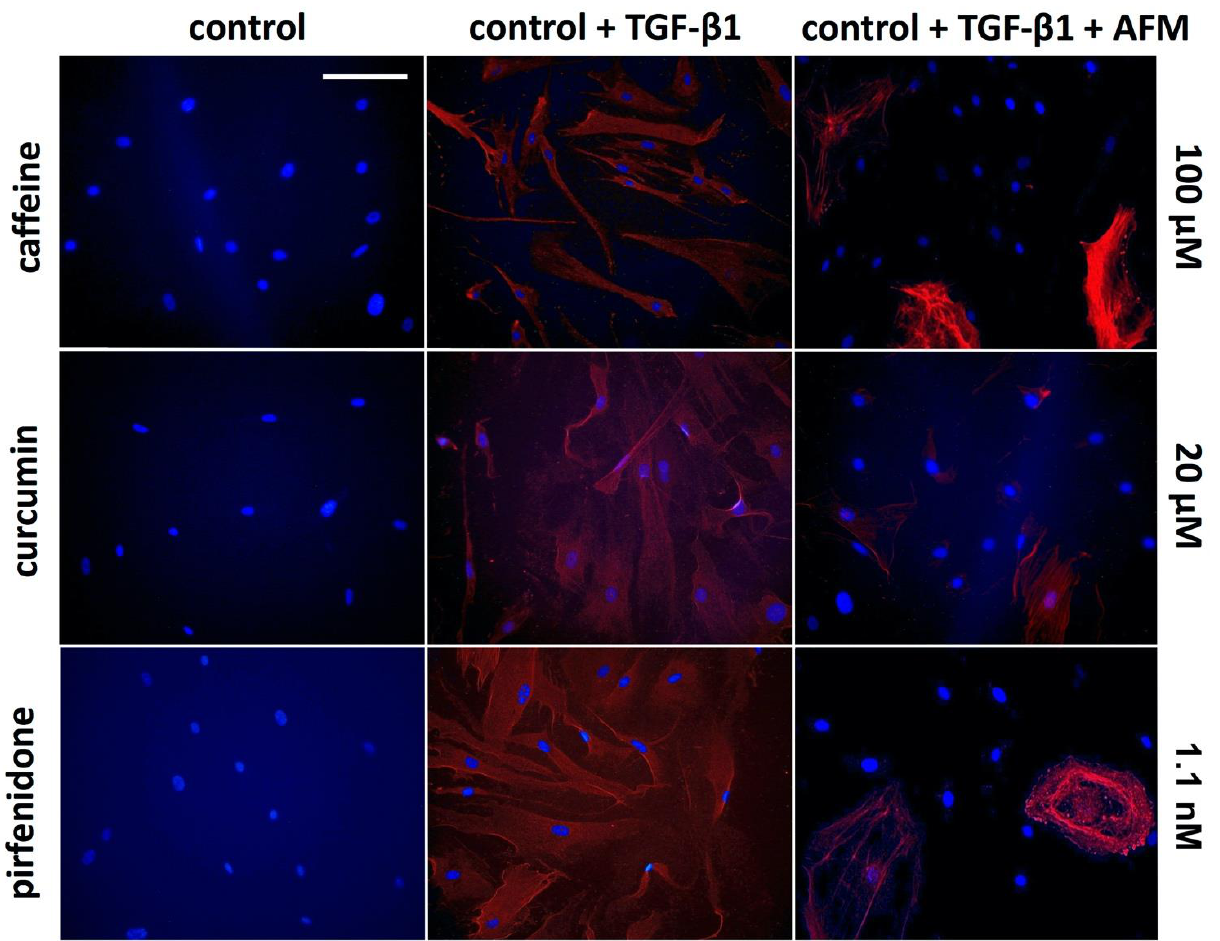
Figure 4. Immunhistochemistry for α - smooth muscle actin (SMA, red) and 4′,6 -diamidino-2-phenylindole (DAPI, blue) in activated corneal stromal keratocytes (aCSK) after incubation for 48 h in media containing the indicated concentrations of the antifibrotic molecules (AFM) caffeine, curcumin and pirfenidone, with and without the profibrotic cytokine 10 ng/mL TGF- β1. Scale bar: 100 µm.